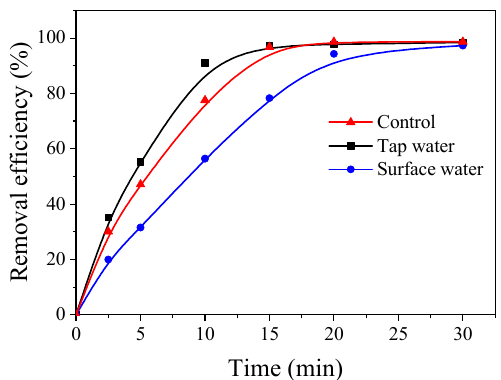
Figure 5. The degradation of Et-PABA in real water using the UV/PDS process. Conditions: [Et-PABA] = 0.05 mM, [PDS] = 2.0 mM, and without pH adjustment.